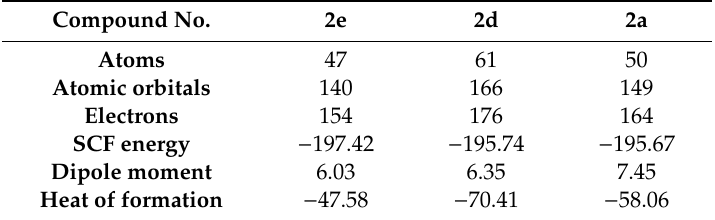
Table 10. Molecular mechanics parameters for the selected target compounds. Compound